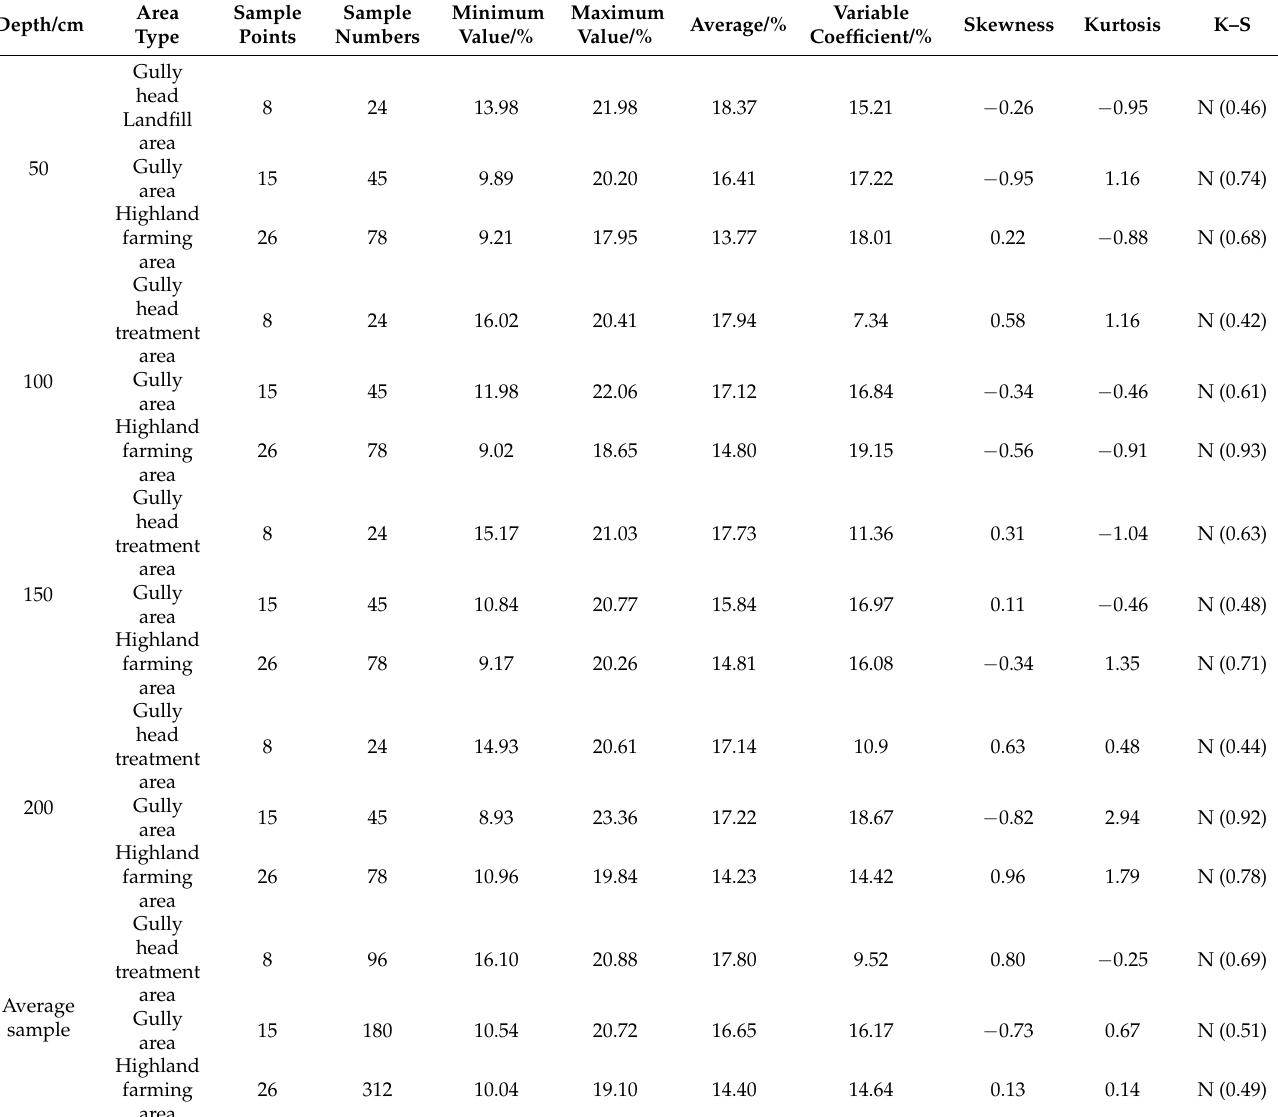
Table 2. Statistical characteristics of the soil moisture at different